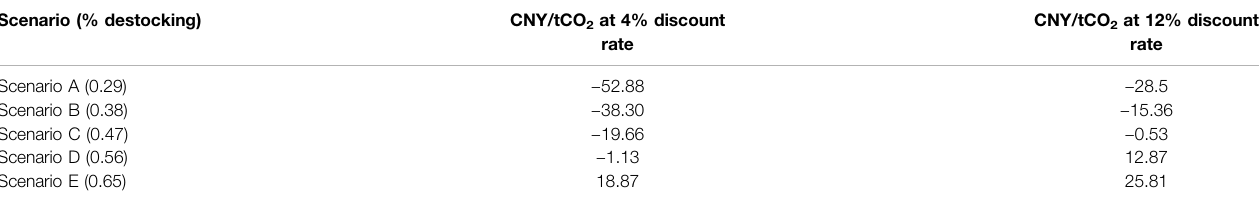
TABLE 6 | Estimated payments to the household per ton of carbon at which net incremental incomes are positive in each with-project scenario modeled (Chinese Yuan,